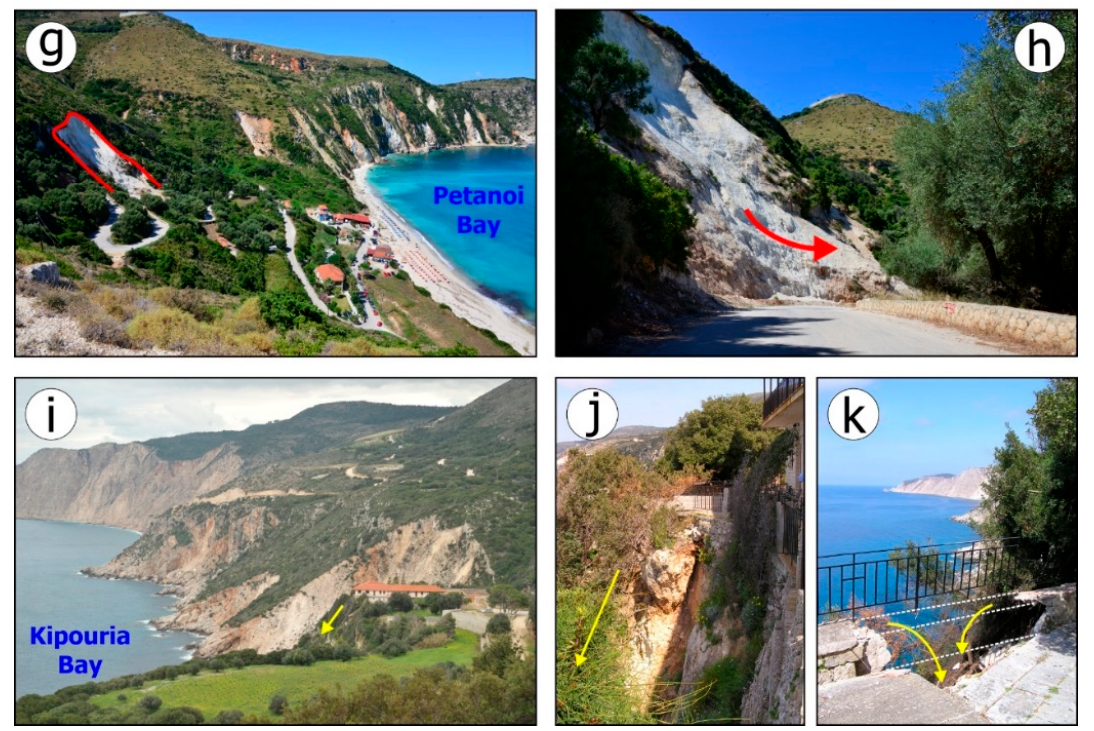
Figure 5. The 2014 ELT in Cephalonia: ( a ) The landslide-prone Myrtos coastal area. ( b ) Water turbidity in Myrtos Bay after the 26 January 2014 earthquake attributed to rockfalls along the adjacent coastal slopes. ( c ) Rockfalls by the early 2014 Cephalonia earthquakes over the Myrtos beach and at Charakas site. ( d ) The landslide-prone eastern margin of Thinia valley, where the Kontogourata– Agonas fault occurs. Rockfalls and slides triggered in Cephalonia by the early 2014 earthquakes: ( e , f ) Unstable limestone boulders in Atheras village in north Paliki crushed trees and a building. ( g , h ) Slides in Petanoi coastal area resulting in traffic disruption. ( i – k ) Rockfalls close to the Kipouraioi monastery affecting its yard.